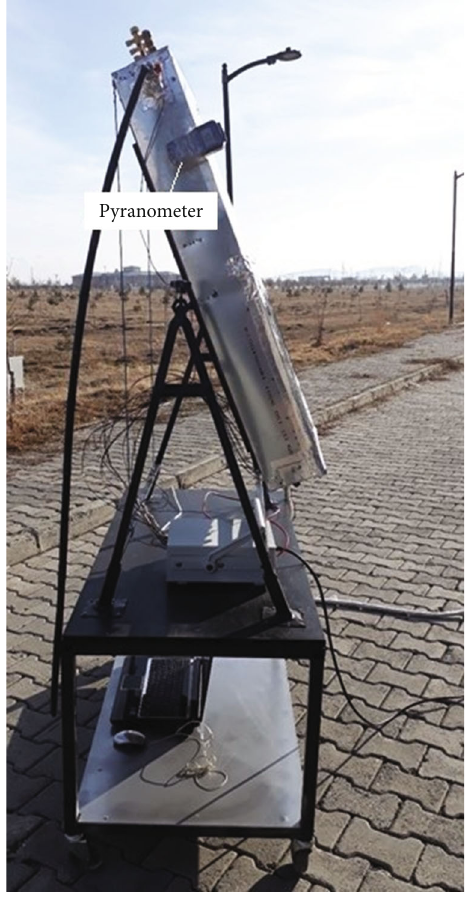
Table 6: Uncertainty calculated parameters and uncertainty